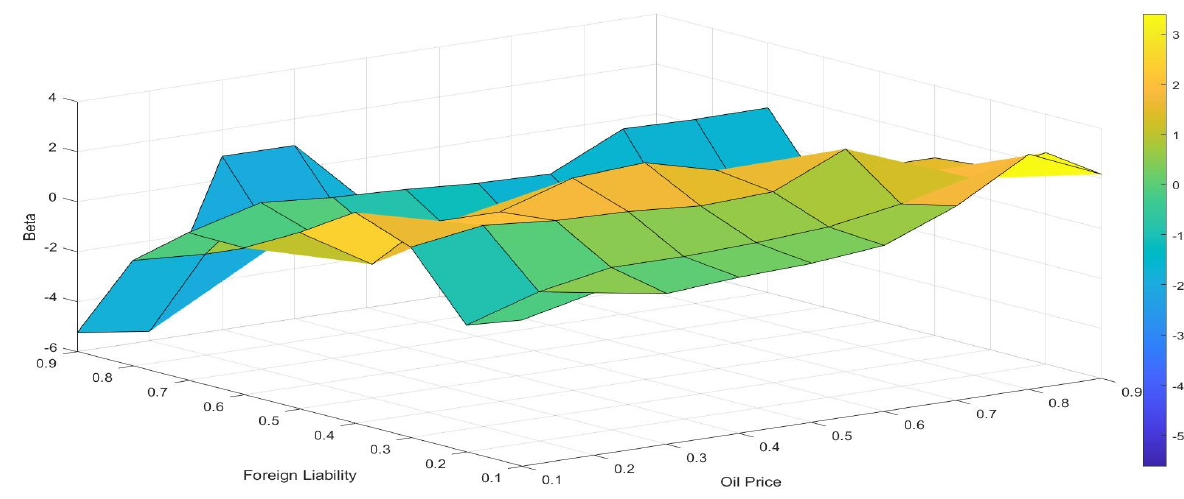
Figure 6. Response of foreign liabilities to oil price. Monthly data.